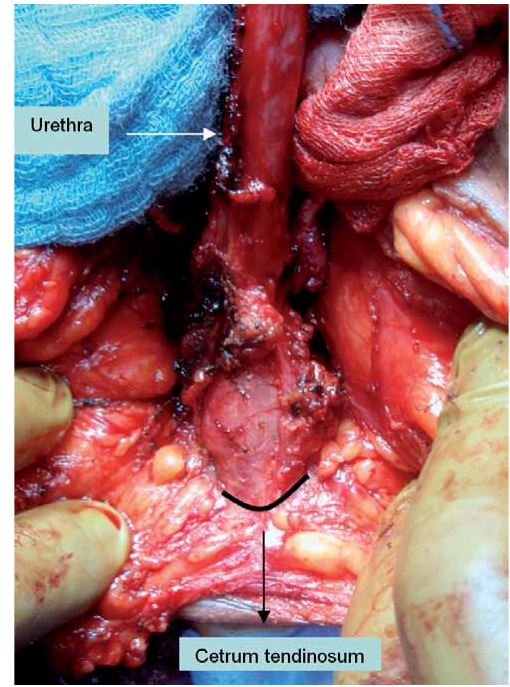
Figure 3 – Identification of the centrum tendineous and urethral retraction preceding dissection of vaginal